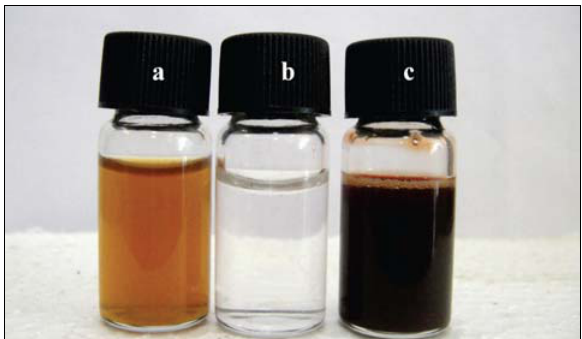
Figure 2. Photographs of: (a) aqueous extract of date fruits, (b) 10 mM of aqueous AgNO solutions, and (c) Colloidal aqueous Ag 3 with Date fruit NPs solution formed by reduction of AgNO 3